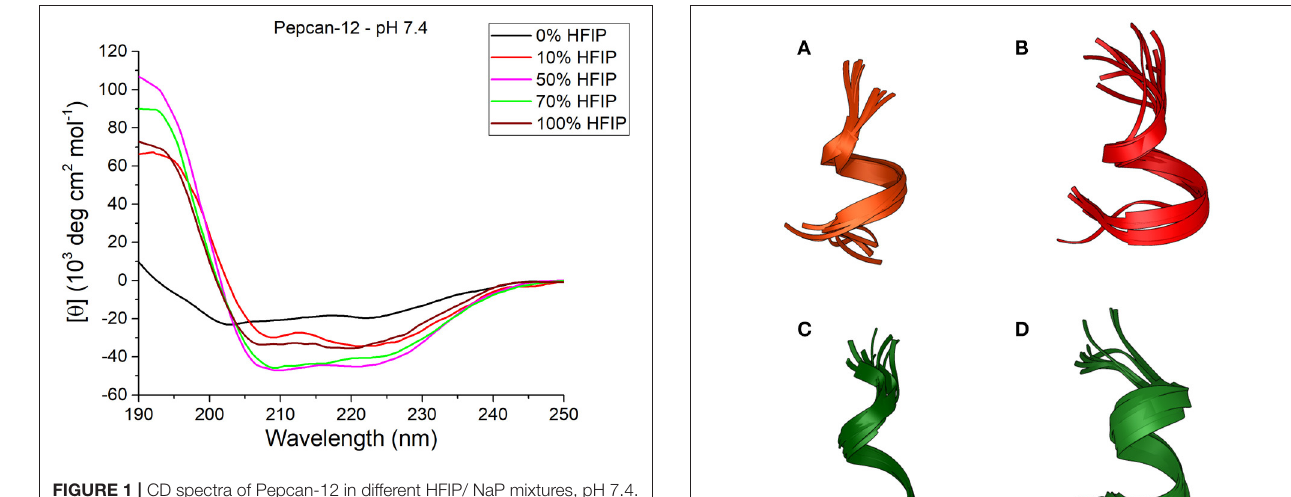
FIGURE 1 | CD spectra of Pepcan-12 in different HFIP/ NaP mixtures, pH 7.4. The appearance of a signal diagnostic of helical secondary structure is visible in the presence of as little as 10% HFIP.